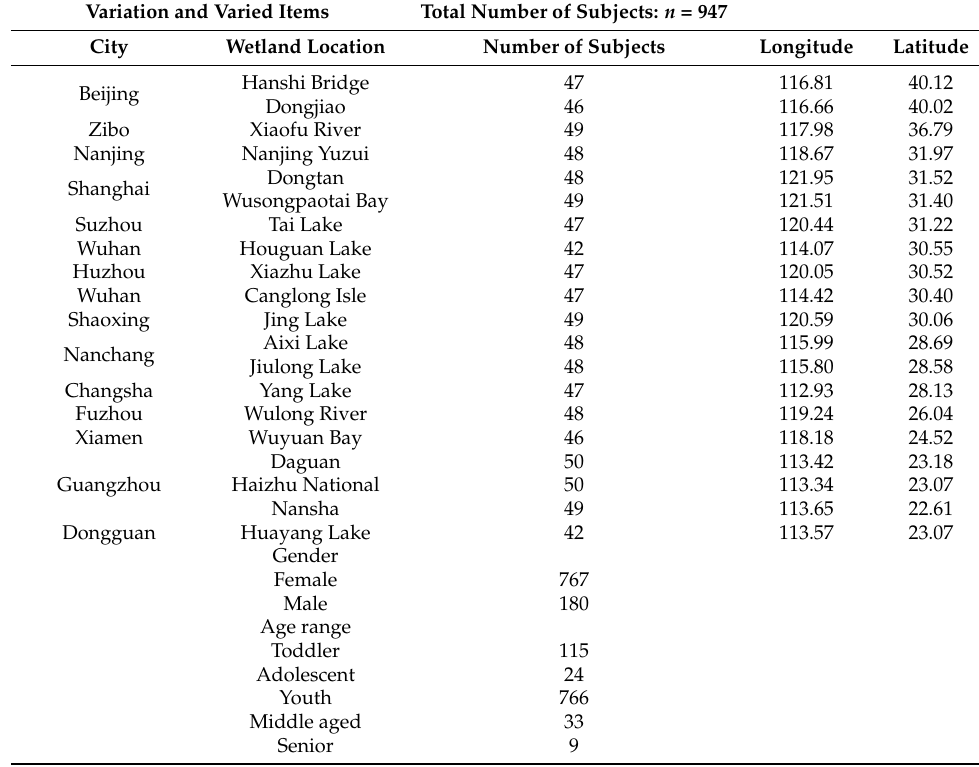
Table 1. Basic information about numbers of facial photo subjects in different wetland locations and varied genders and ages of visitors